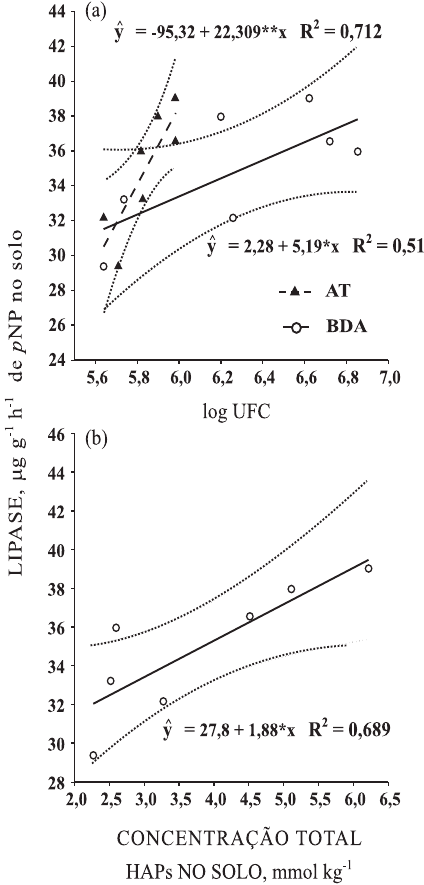
Figura 3. Equações de regressão entre a atividade da lipase e a contagem de bactérias degradadoras e actinomicetos totais (a), e entre a concentra- ção molar total de hidrocarbonetos semivoláteis extraíveis e a atividade da lipase (b) em solos de área de “landfarming” de resíduos petroquímicos. BDA (Bactéria degradadora de antraceno), AT (Actinomiceto total). Linhas pontilhadas repre- sentam o intervalo de confiança da amostragem a 95 % de probabilidade. *,** regressão signifi- cativa pelo teste t de Student a 5 e 1 %, respecti-